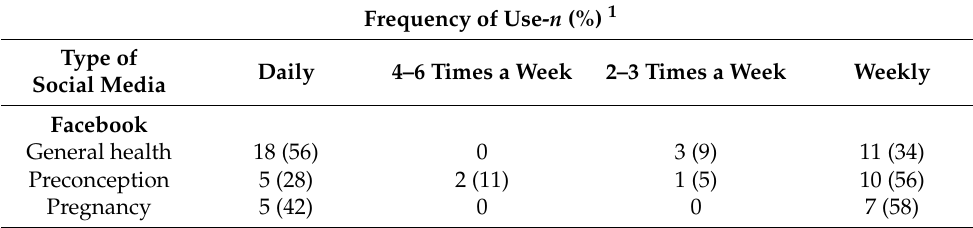
Table 3. Frequency of social media use for each type of